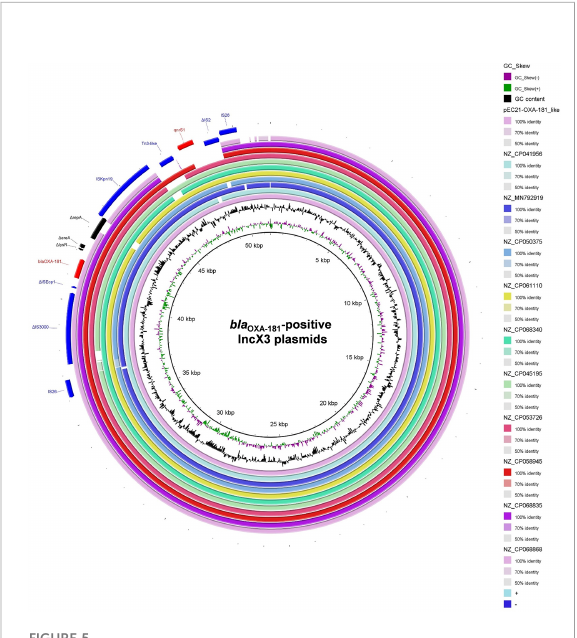
FIGURE 5 Schematic map of bla OXA-181 -associated genetic structures identi fi ed among the 66 bla OXA-181 -positive IncX3 plasmids in Enterobacterales . The pEC21-OXA-181_like represent the 56 plasmids carrying the intact IS 26 - fl anked composite transposon.